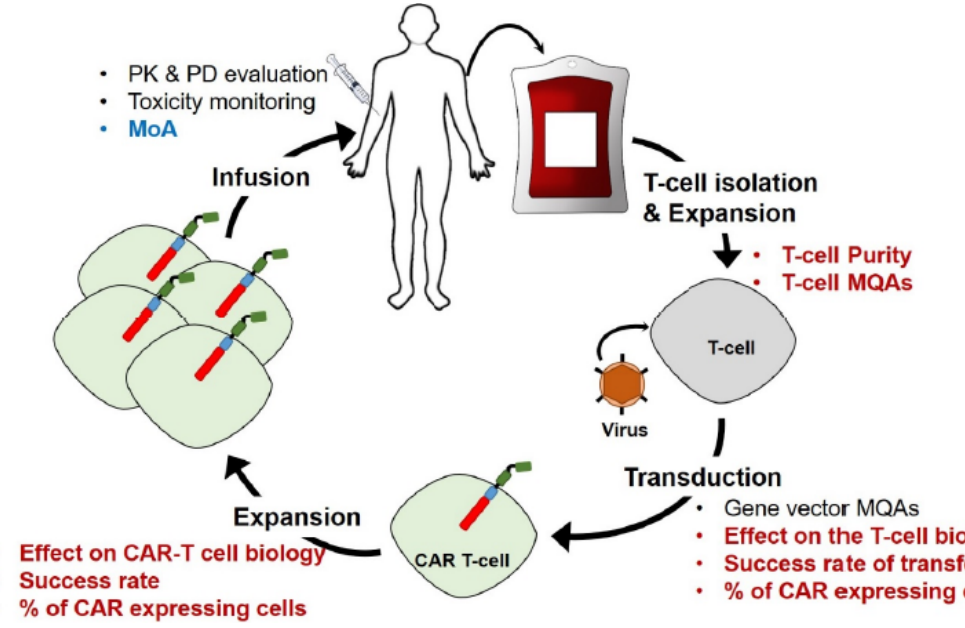
Figure 1. Schematic overview of the biomanufacturing of chimeric antigen receptor (CAR)-T cell therapies. The cycle starts with the isolation and expansion of T-cells from patient’s blood. The cells are then transduced to express the CAR by genetic engineering using a disarmed viral vector. Then the cells are expanded to multiply and differentiate into CAR-T cells targeting the select tumor antigen and are finally infused back into the patient. Steps of the manufacturing that would greatly beneficiate from MS-based proteomic characterization are highlighted in bold red font. The bold blue font indicates area where MS-based proteomics has previously been utilized.